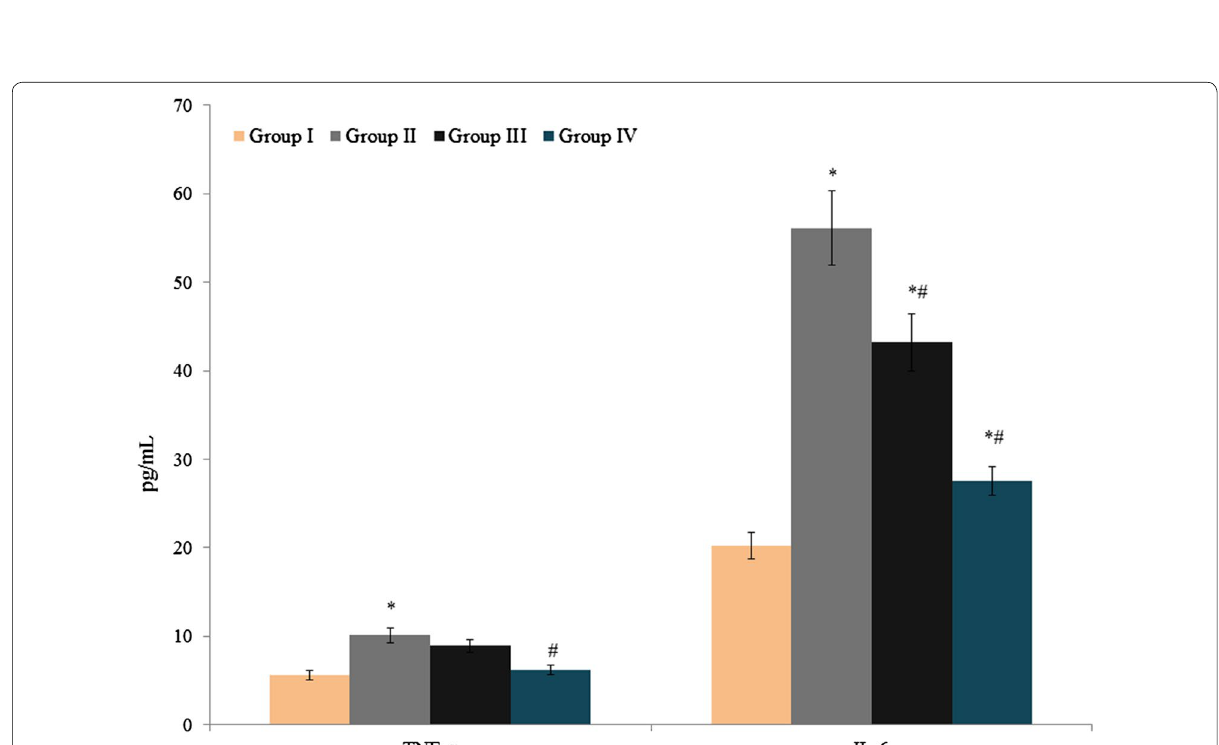
Fig. 1 Effect of atorvastatin and amygdalin on tumor necrosis factor-alpha (TNF-α) and interleukin-6 (IL-6) levels in the peritoneal fluid of Sprague-Dawley rats with experimentally induced endometriosis. Values are expressed in pg/ml. * P < 0.05 vs. group I (sham-operated rats) and # P < 0.05 vs. group II (non-treated endometriosis control